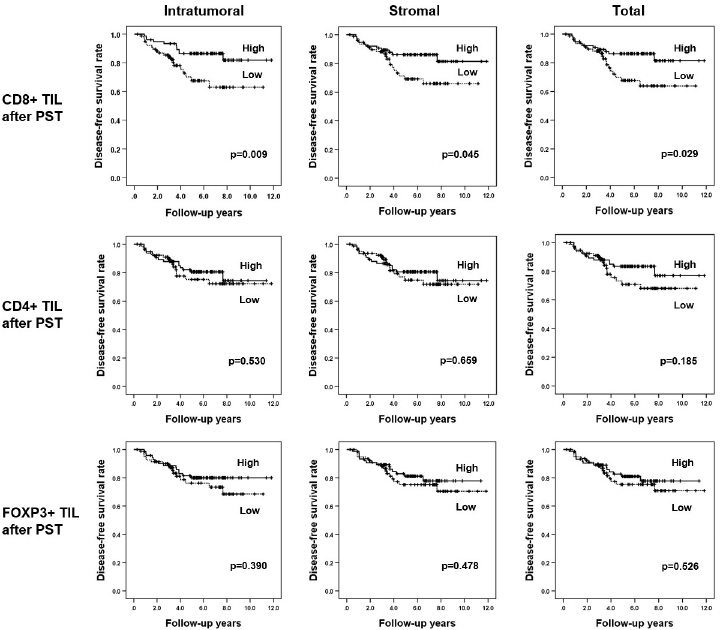
Fig 2. Kaplan-Meier survival analyses according to the level of tumor-infiltrating lymphocyte subsets in each compartment in post-primary systemic therapy samples. High levels of the intratumoral, stromal, and total CD8 + tumor-infiltrating lymphocyte (TIL) infiltration after primary systemic therapy (PST) are associated with longer patient disease-free survival, whereas levels of CD4+ and FOXP3+ TIL filtration after PST have no prognostic significance.